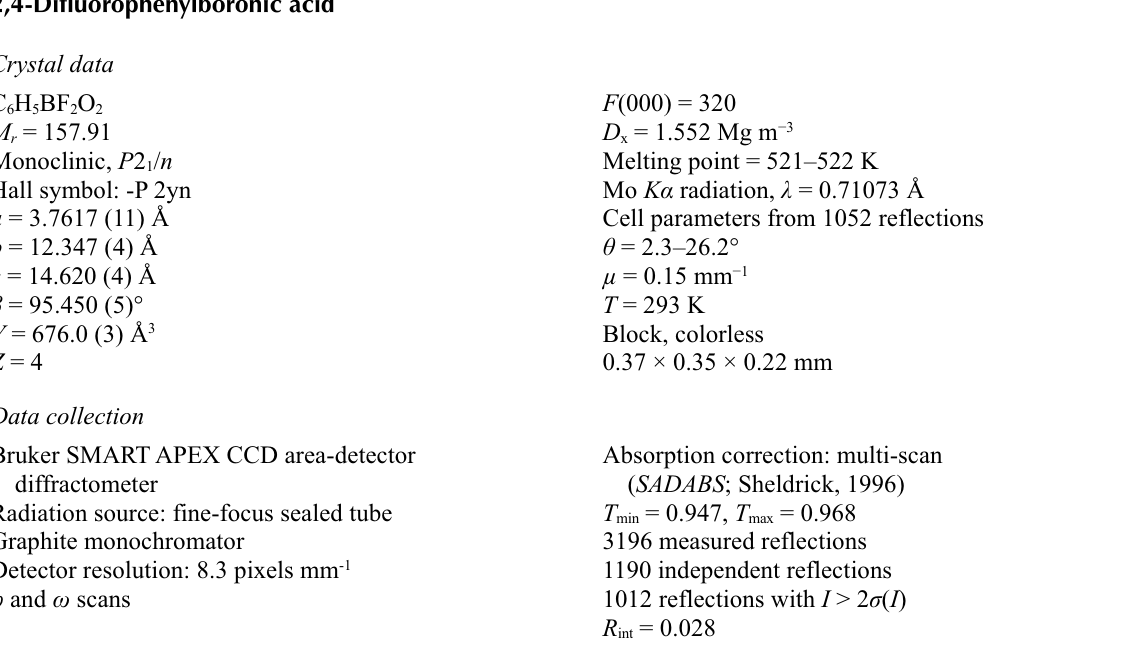
Figure 2 View of the packing arrangement of the two-dimensional network of (I)(I) . 2,4-Difluorophenylboronic